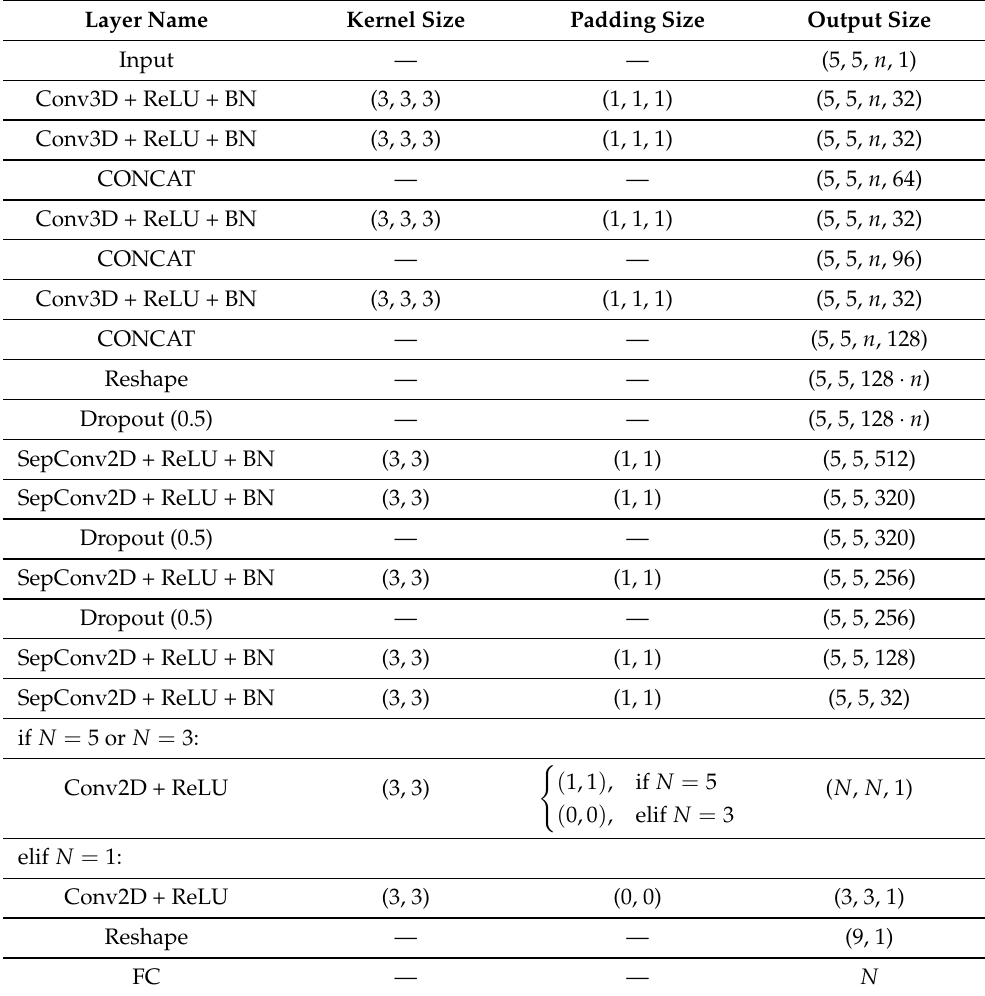
Table 3. Hyper3DNetReg